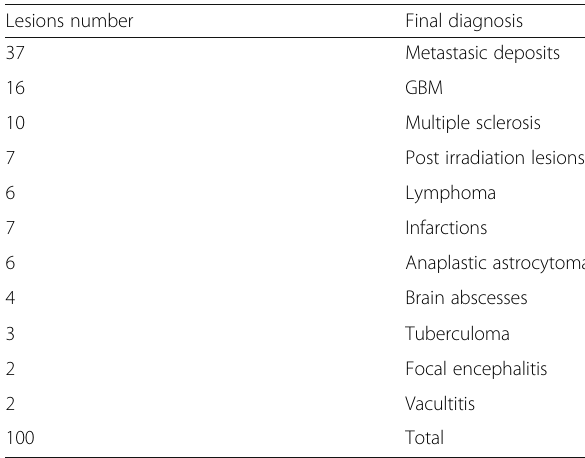
Table 1 Histo-pathological results and final clinical diagnosis of the studied 100 lesions Lesions number